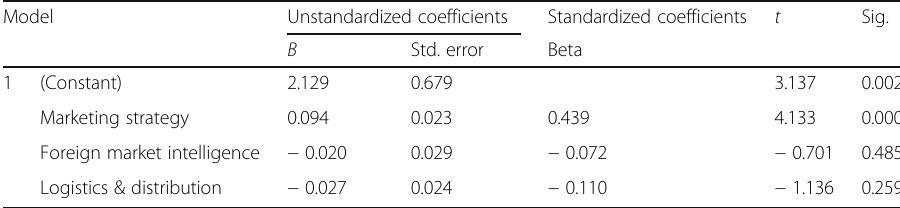
Dependent variable: global